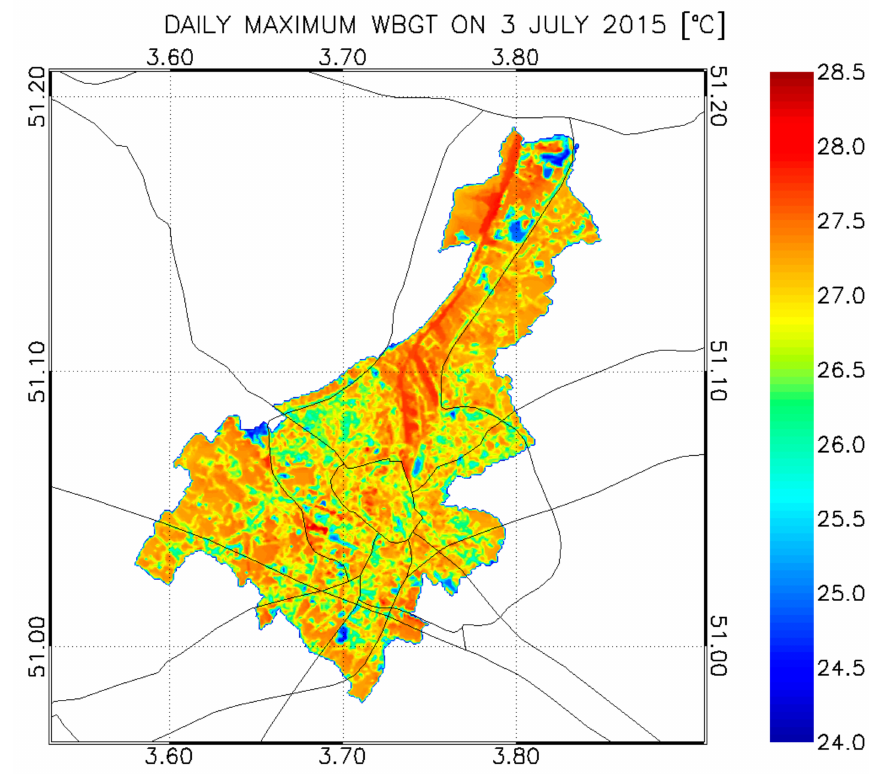
Figure 5. Map of the daily maximal wet bulb globe temperature for the city of